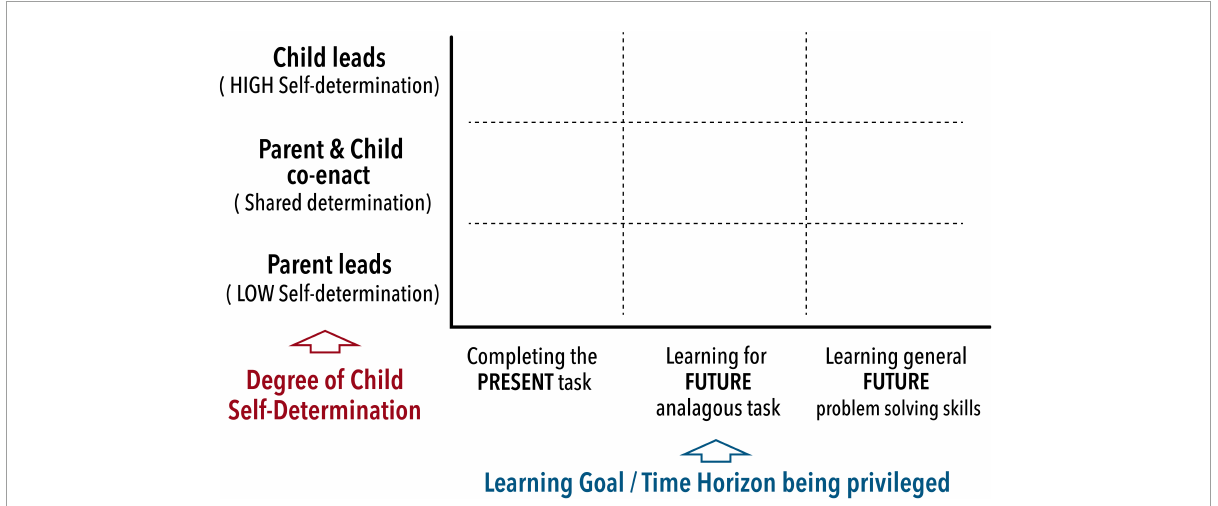
FIGURE1 A 3 × 3 plot to prompt our analysis of each problem-solving arc. The categories on the y -axis prompt us to consider which participant leads the interaction, while the categories on the x -axis prompt us to consider what goals and time horizons are being given priority.